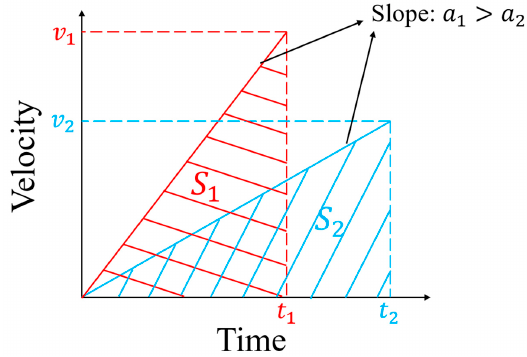
Figure 3. Comparison of two acceleration processes. A higher loading rate of shock impact means greater acceleration at each moment, which that means a higher velocity at the collision.